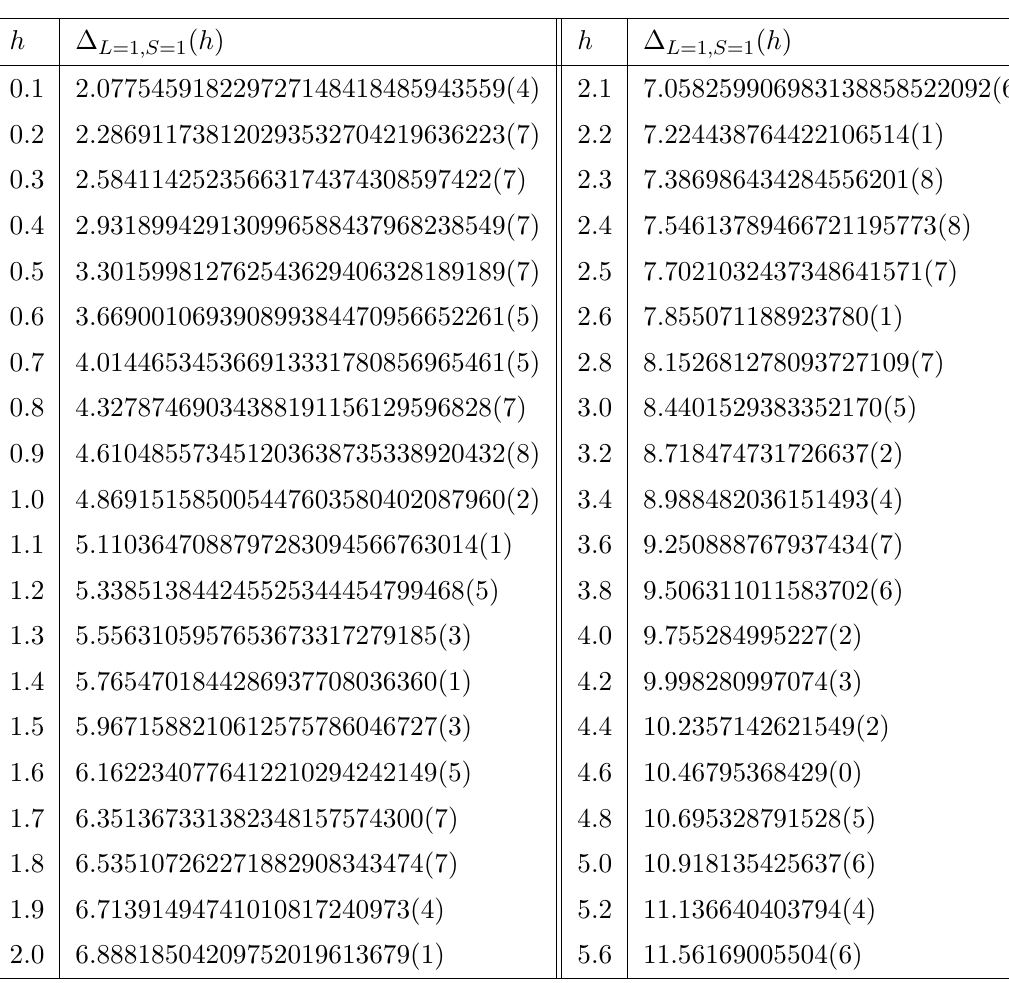
Table 6 . Numerical results for (cid:1) L =1 ;S =1 ( h